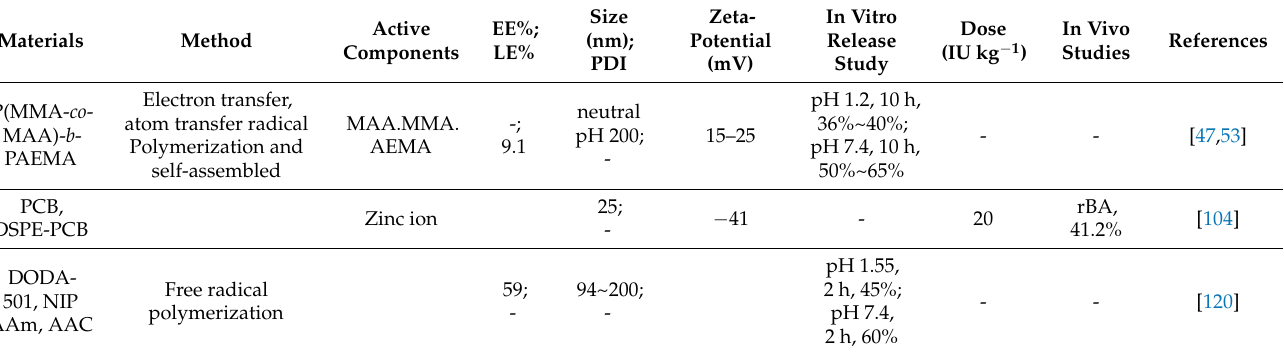
Table 4. Examples of micelles as nanostructures for oral insulin delivery nanosystems.